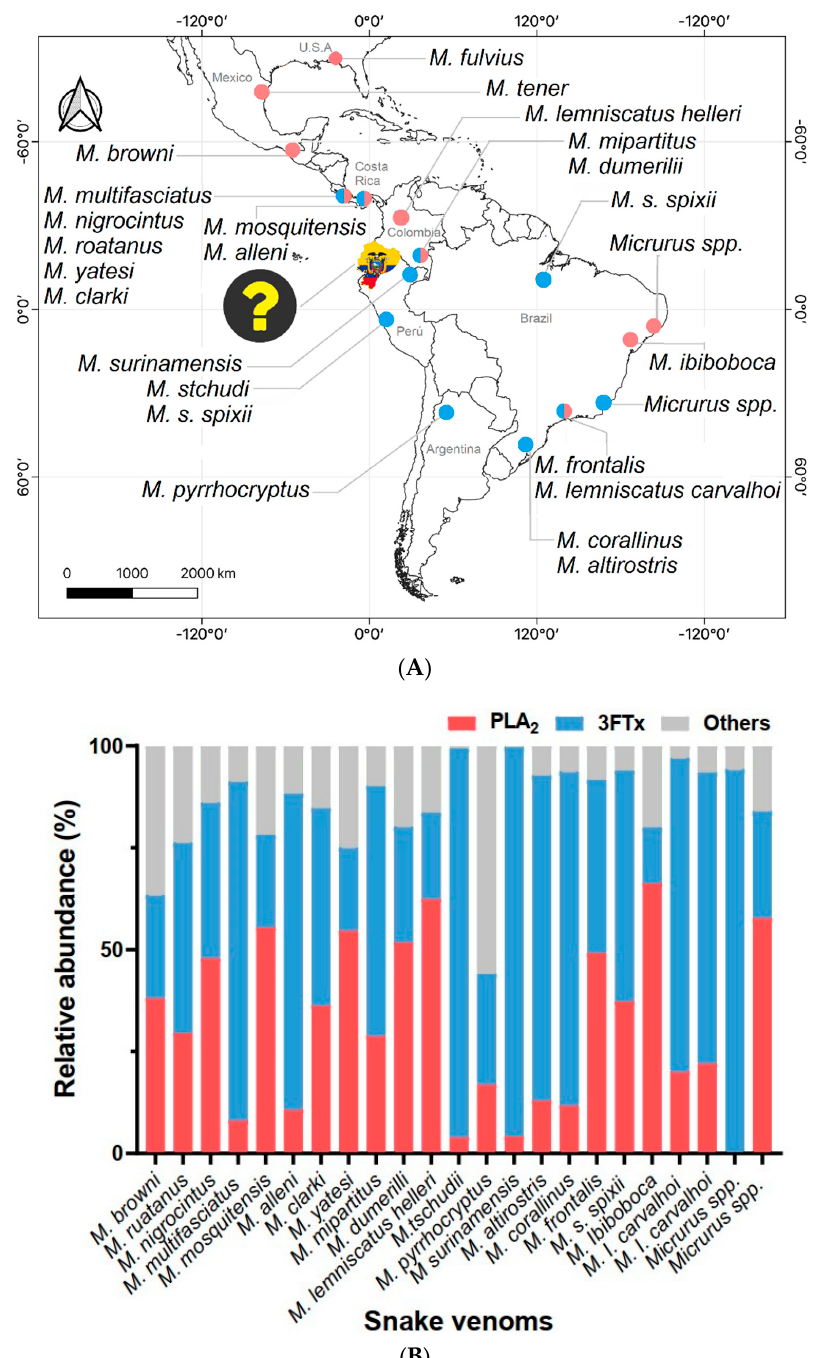
Figure 1. The current knowledge about Micrurus venom in the literature. ( A ) Micrurus specimens collected from different countries such as Argentina, Brazil, Colombia, Costa Rica, Mexico, and United States were proteomically characterised (dots represent geographical sites where analysed venoms/specimens were collected). However, the composition of Ecuadorian coral venom is still unknown. The question mark (yellow) points out this gap in the understanding of coral snake venoms in a biodiverse region. Red dots represent specimens with a PLA 2 -predominant profile, while blue dots highlight venoms with a higher abundance of 3FTXs. Dual-colour dots illustrate regions where both compositional patterns have been identified. ( B ) Detailed profile of key venom toxins in Elapid snake venoms. PLA 2 -dominant or 3FTx-dominant profiles dictate an intriguing general trend in the distribution of proteins in venoms along the American continent.